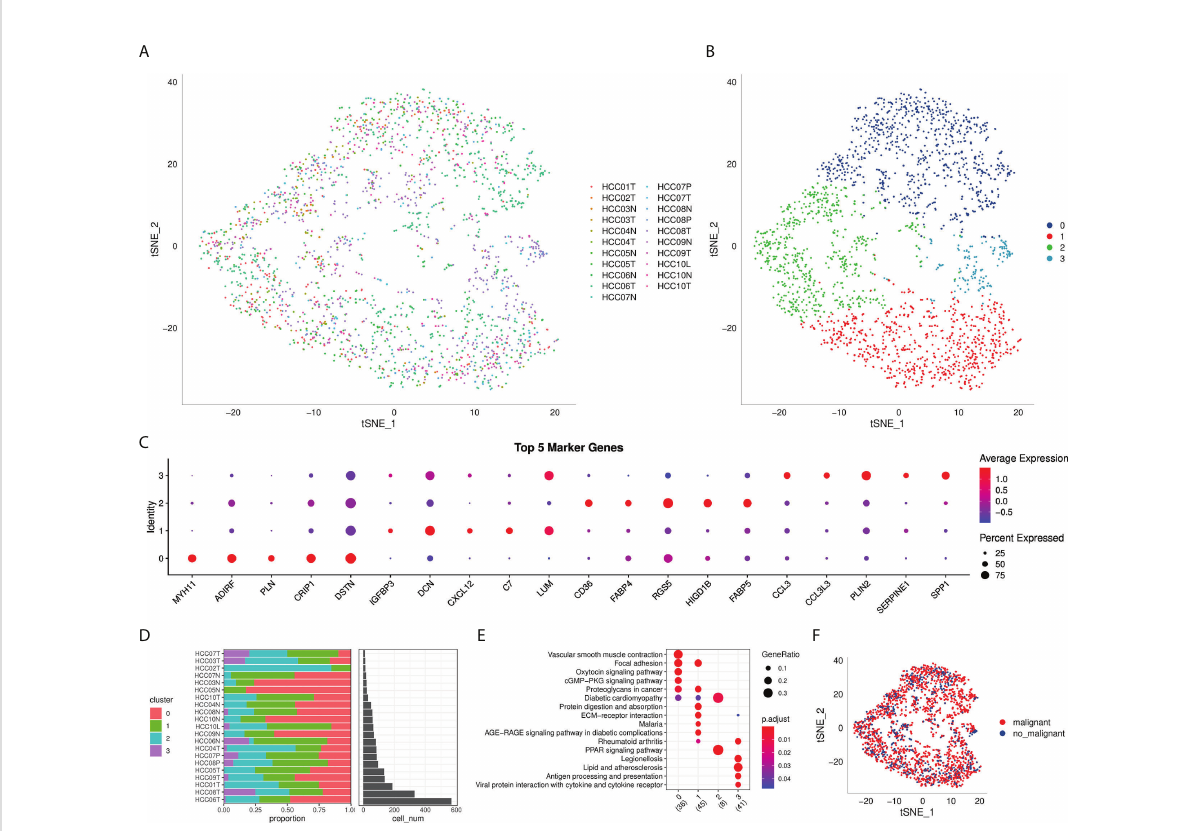
FIGURE 2 The identi fi cation of CAF clusters based on scRNA seq data of HCC patients. (A) tsne plot of the distribution of 21 samples; (B) tsne plot of the distribution of four fi broblasts after clustering; (C) dot plot of the top 5 marker gene expression of subgroups; (D) subgroups in cancer tissue and Proportion and cell number of adjacent tissue; (E) kegg enrichment analysis of 4 fi broblast subsets; (F) tsne distribution map of malignant and non-malignant cells predicted by copykat